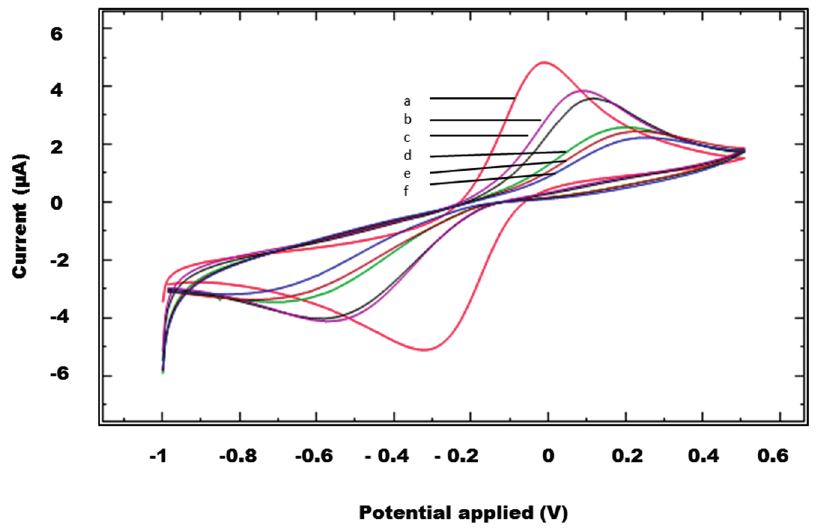
Figure 4. Cyclic voltammetries of the unmodified and modified SPCEs: ( a ) unmodified